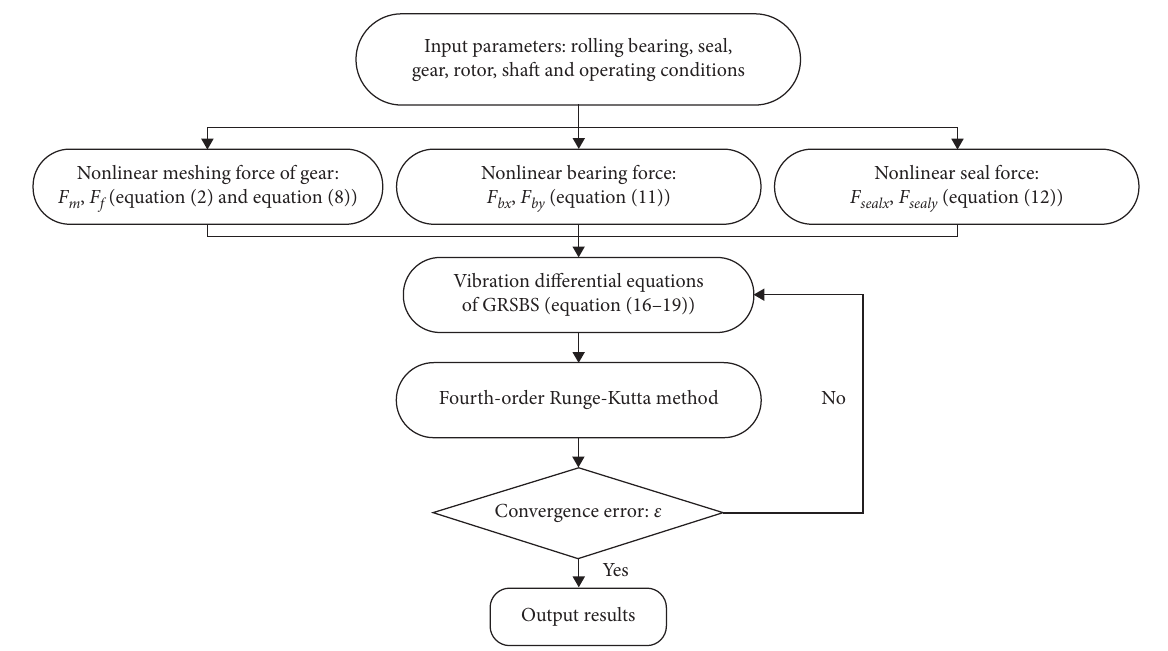
Figure 5: Block diagram of the nonlinear global calculation program.